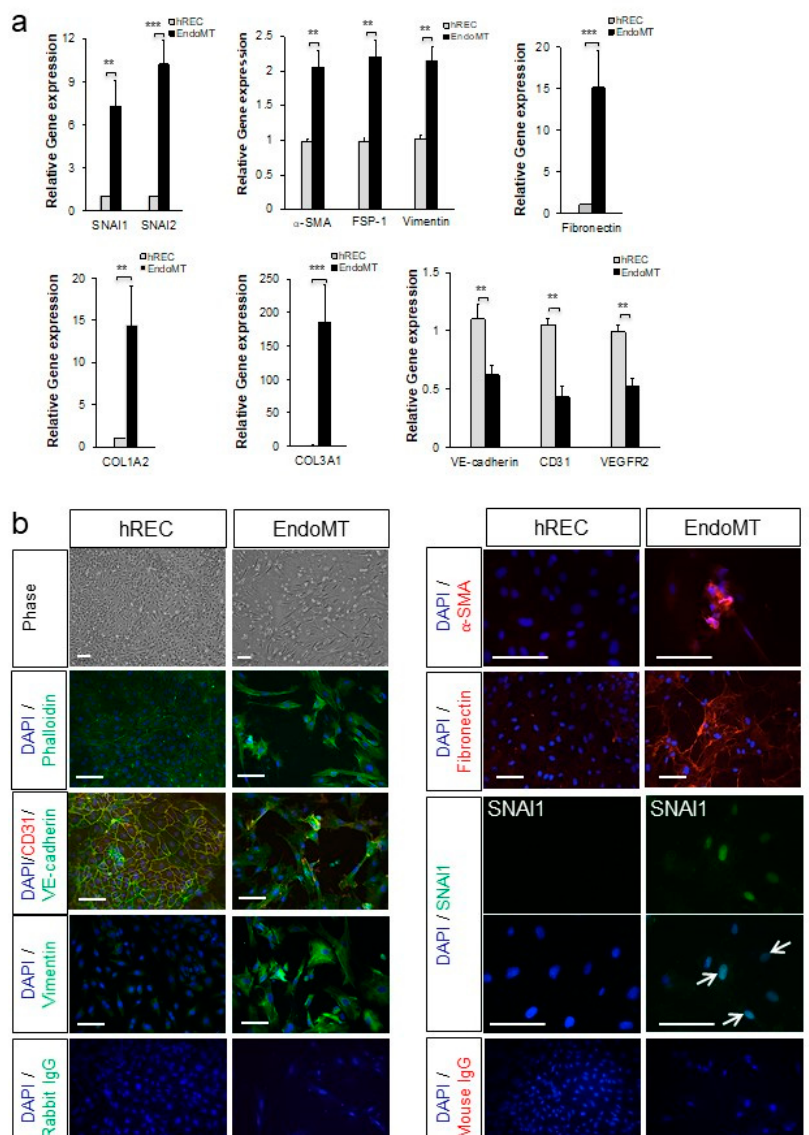
Figure 1. Primary human retinal endothelial cells (hREC) can be used to model endothelial-to-mesenchymal transition (EndoMT) in vitro. ( a ) Expression levels for the genes encoding the EndoMT-associated proteins SNAI1, SNAI2, α -SMA, FSP-1, vimentin, fibronectin, COL1A2, and COL3A1; and the endothelial differentiation markers VE-cadherin, CD31 and vascular endothelial growth factor receptor-2 (VEGFR2), are shown relative to the housekeeping gene HPRT1 and normalized to the control hREC as assessed by qPCR on day 6 of EndoMT induction. Data = mean ± SEM, ** p < 0.01, *** p < 0.001 compared to the control hREC by unpaired 2-tail t-test, n = 4 (VE-cadherin), 6 (collagen type III alpha 1 chain (COL3A1)), 8 (SNAI1, α -smooth muscle actin ( α -SMA), fibroblast-specific protein 1 (FSP-1), CD31), 9 (vimentin), 10 (fibronectin, VEGFR2), and 11 (SNAI2, COL3A1) independent wells per group. ( b ) Histological analysis of EndoMT cells on day 6 of EndoMT induction. Phase contract microscopy and phalloidin staining (green) in the top four panels on the left illustrate the distinctions in cellular morphology between hREC and EndoMT cells. Alterations in expression and localization of endothelial di ff erentiation markers CD31 and VE-cadherin and the mesenchymal markers vimentin, α -SMA, fibronectin and SNAI1 between hREC and EndoMT cells are also shown. Note the nuclear localization of SNAI1 (green, arrows) in EndoMT cells whereas the control hREC do not display SNAI1 expression. Isotype-matched IgG staining controls are shown on the bottom rows. Scale bars = 100 µ